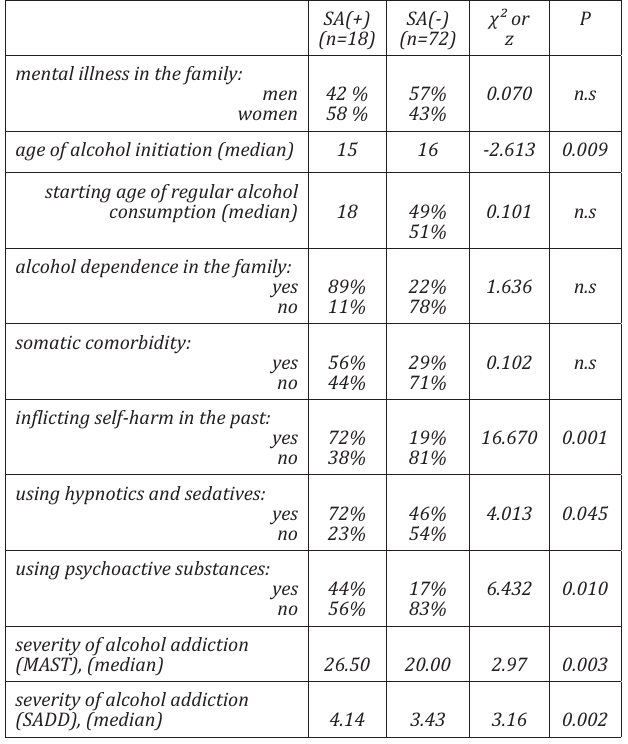
Table 1. Comparison of socio - demographic variables in people with and without a history of suicide attempts gender: